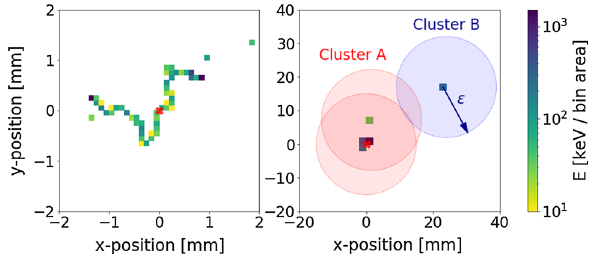
Fig. 2 Simulated energy deposition (color scale) of two different 0 νββ -events in the x - y -plane. Left: The two electrons thermalize along two non-resolvable back-to-back tracks. The emitted Bremsstrahlung photons yield detached energy depositions. Right: A O (400keV) pho- ton Compton scatters 8mm from the position of the decaying 136 Xe nucleus and travels more than 2cm without energy loss before absorp- tion. The circles indicate the boundaries of individually resolvable clus- ters assuming a separation threshold (cid:7) = 15mm Fig. 3 Efficiency of 0 νββ signal acceptance and background rejection